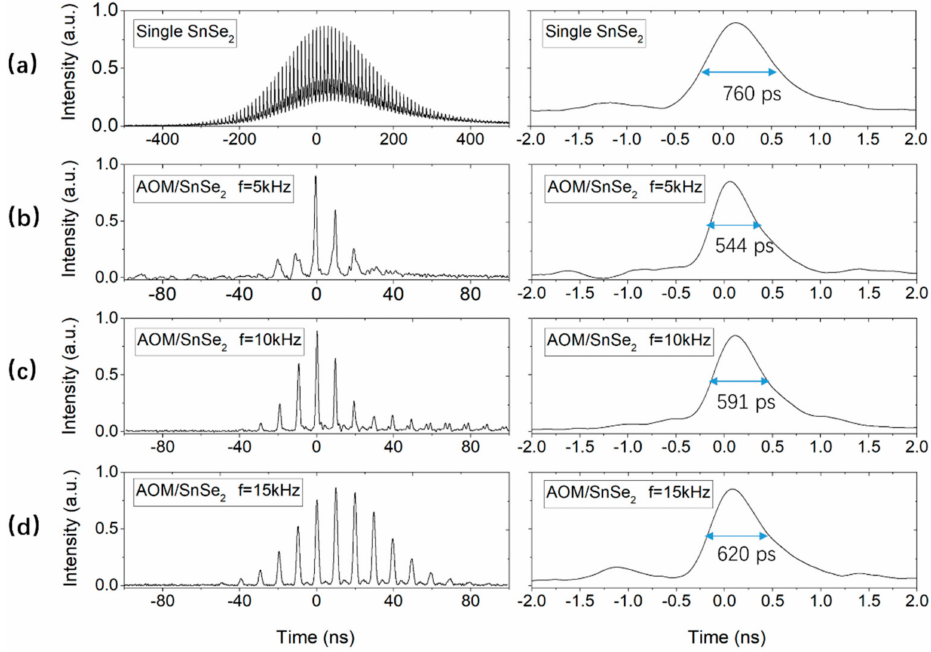
Figure 7. The temporal shapes of QML pulse envelope and single mode-locking pulses with different modulation methods at the pump power of 8.5 W: ( a ) single QML laser with SnSe 2 ; ( b ) APDM OML laser with f = 5 kHz; ( c ) APDM OML laser with f = 10 kHz; ( d ) APDM OML laser with f = 15